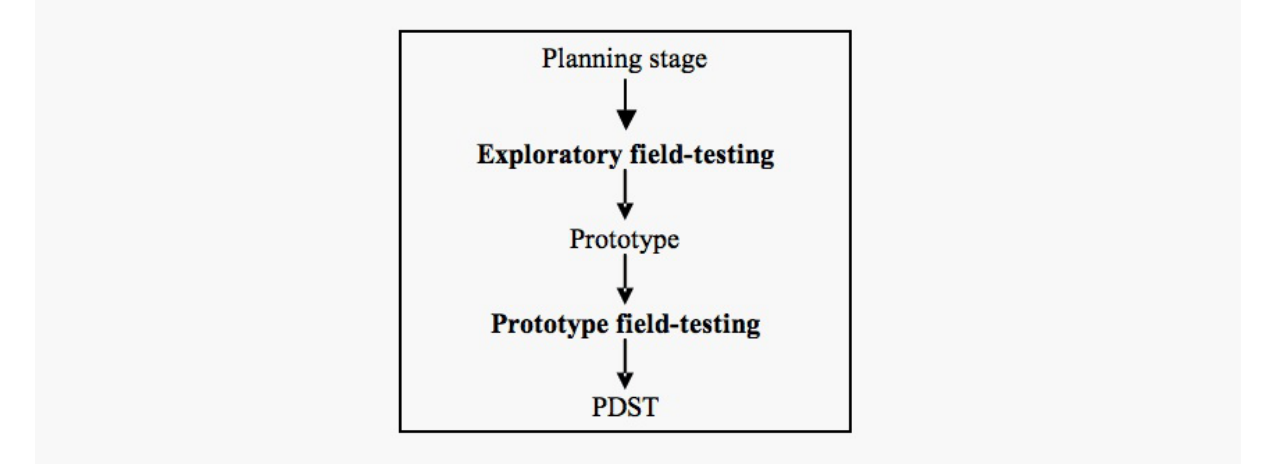
Figure 2. Proposed model for field-testing